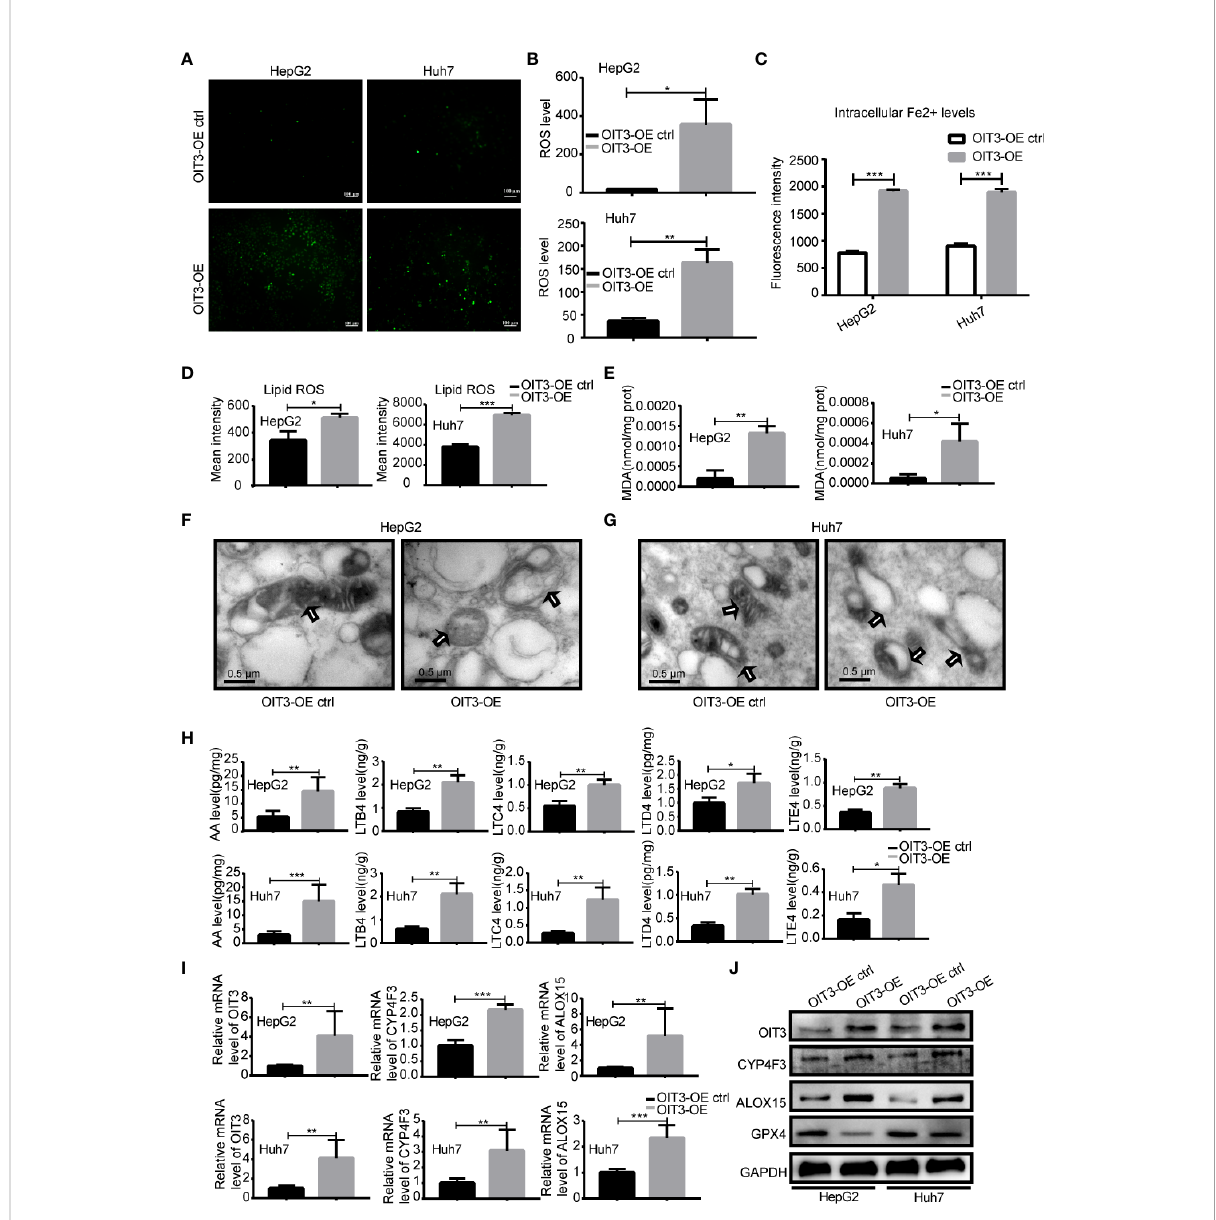
FIGURE 7 OIT3 promoted the ferroptosis of HCC cells in vitro . (A, B) The ROS level in HepG2 and Huh7 cells with different OIT3 expression. ( *P < 0.05 , **P < 0.01 ). (C) The intracellular Fe 2+ level of HepG2 and Huh7 cells with different OIT3 expression. ( ***P < 0.001 ). (D) The lipid ROS level in HepG2 and Huh7 cells with different OIT3 expressions. ( *P < 0.05 , ***P < 0.001 ). (E) The effect of OIT3 expression on the production of MDA in HepG2 and Huh7 cells. ( *P < 0.05 , **P < 0.01 ). (F, G) Transmission electron microscopy revealed mitochondrial alterations in HepG2 and Huh7 cells with or without OIT3 overexpression (bar=0.5 m m). (H) OIT3 enhanced the level of AA, LTB4, LTC4, LTD4, and LTE4 in HepG2 and Huh7 cells. ( *P < 0.05 , **P < 0.01 , ***P < 0.001 ). (I) OIT3 upregulated the expression of ALOX15 and CYP4F3 at mRNA level ( **P < 0.01 , ***P < 0.001 ). (J) The protein level of ALOX15, CYP4F3, and GPX4 in HepG2 and Huh7 cells with the different expression levels of OIT3. Experiments were repeated three times, and the data are expressed as the mean ± SEM. OIT3-OE, OIT3-overexpressed lentivirus vector; OIT3-OE ctrl, OIT3-overexpressed lentivirus vector control; AA, arachidonic